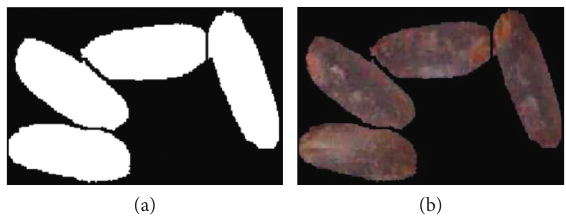
Figure 20: (a) Binary image after segmentation. (b) Germ rice image after segmentation.